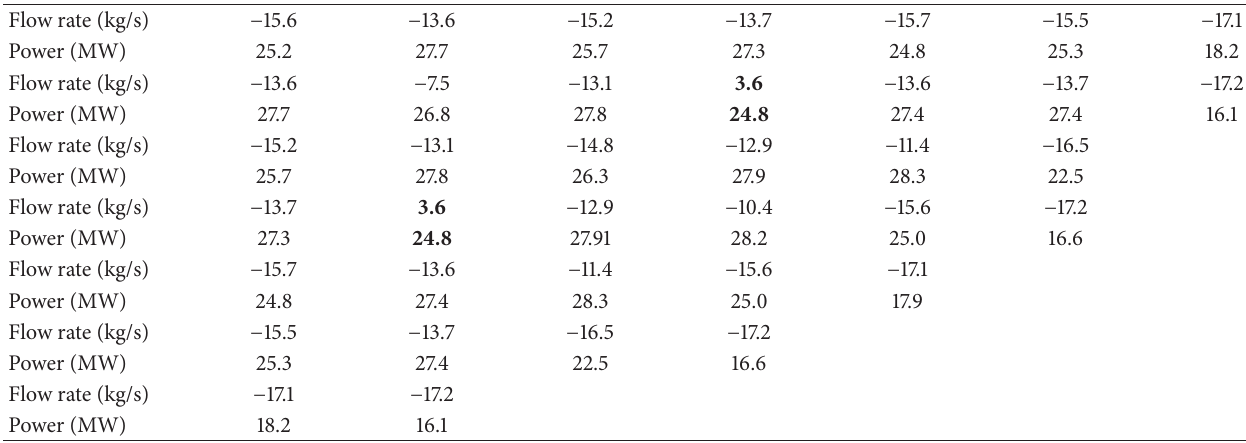
Table 2: Moderator flow rate and assembly power in the reference